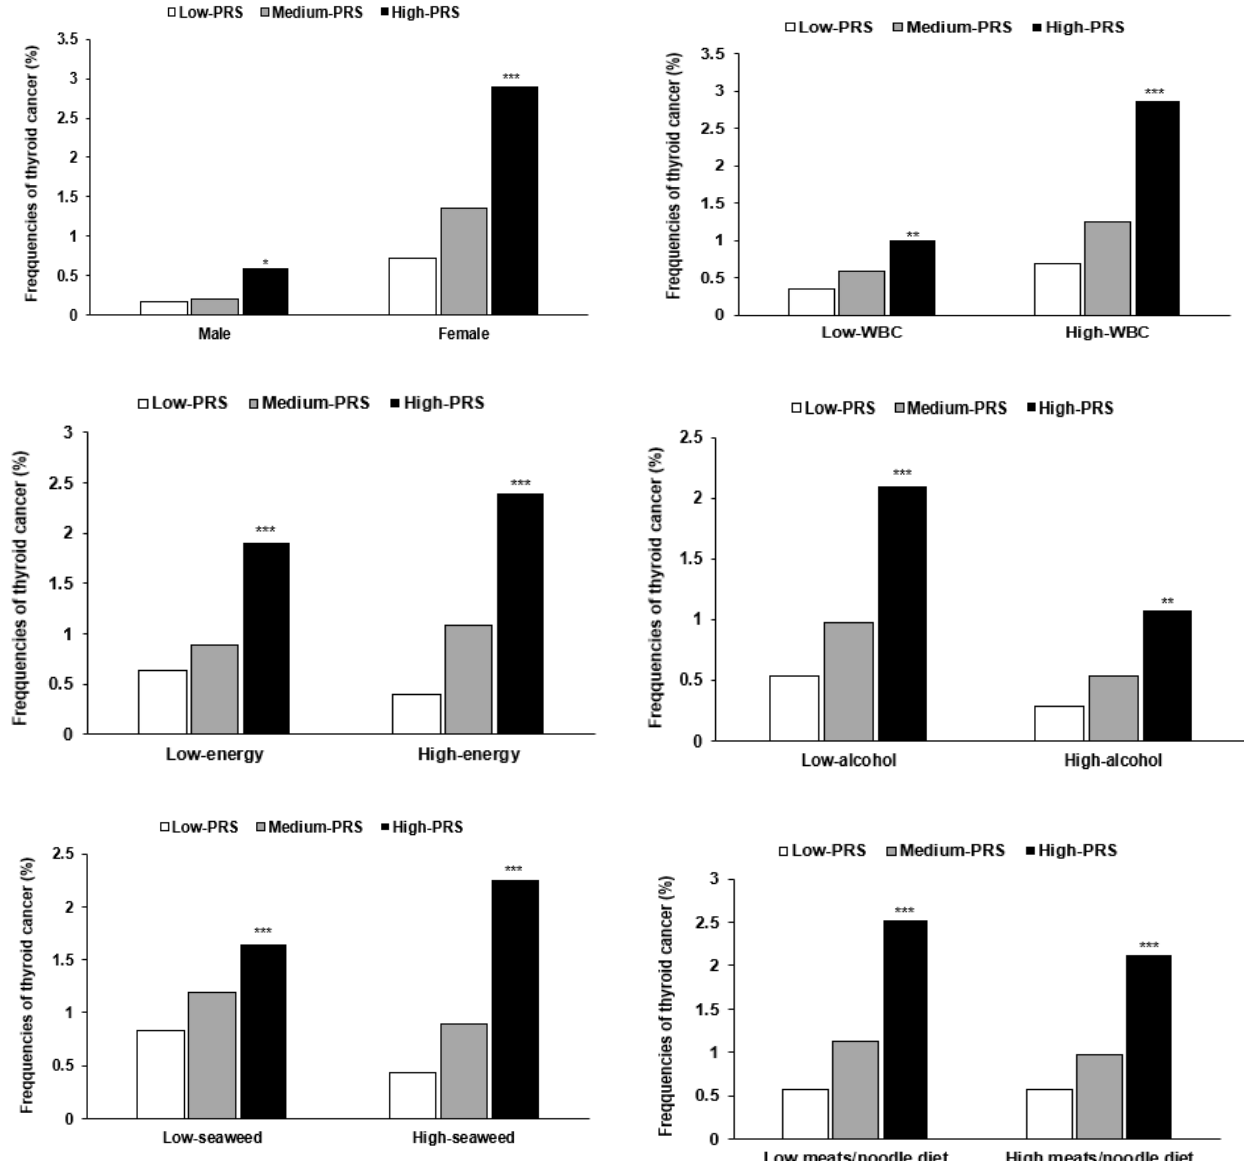
Figure 3. Prevalence of thyroid cancer among subjects in the low-, medium-, and high-PRS groups (determined using the 6 SNP genetic variant–genetic variant interaction model). PRS with 6 SNPs, the best model of GMDR, was divided into 3 categories (0–3, 4–6, and ≥ 7) by tertiles as the low-PRS, medium-PRS, and high-PRS groups. The nutrient and diet variables were categorized into two groups based on the specified cutoff values. The frequencies of thyroid cancer of PRS groups were calculated in low and high intake groups. A. In subjects categorized by gender. B. In subjects categorized by white blood cell count (WBC, cutoff value: 4 × 10 9 /L). C. In subjects categorized by daily energy intake (cutoff value: 100 percent of estimated energy intake). D. In subjects categorized by alcohol intake (cutoff value: 20 g/day). E. In subjects categorized by seaweed intake (cutoff value: 2.65 g/day). F. In subjects with a meats/noodle dietary pattern (cutoff value: 70th percentile). * Significantly different among the PRS groups p < 0.05, ** p < 0.01, *** at p <